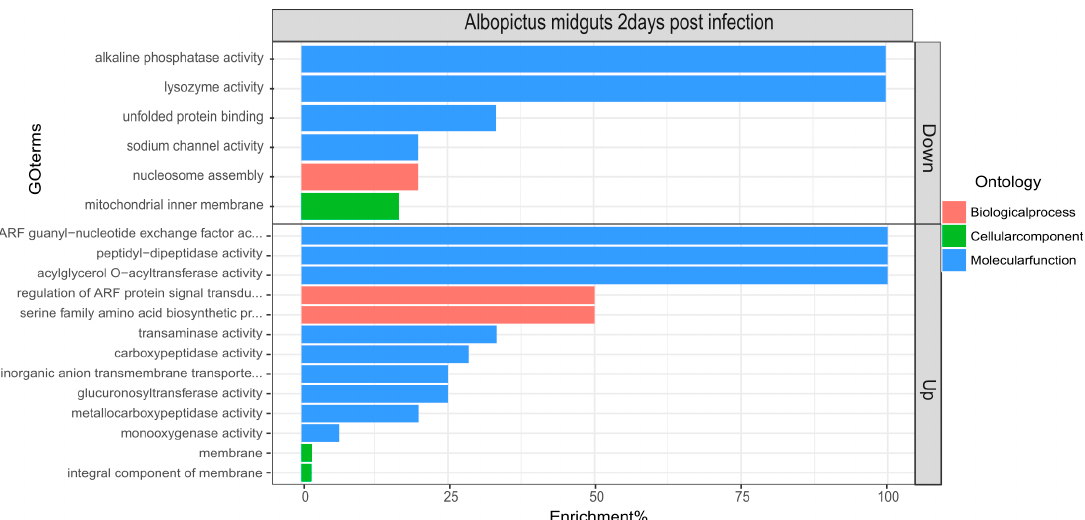
Figure 2. topGo enrichment comparison in differentially expressed genes. Enrichment analysis of down- and upregulated genes in the midguts of Aedes albopictus mosquitoes in response to Chikungunya virus (CHIKV) at 2 dpi. Enrichment % is calculated as the ratio of ‘significant’ (Number of times the gene ontology number is observed as differentially expressed) to ‘expected’ (Number of times the gene ontology number is expected based on observation in control samples) gene numbers.